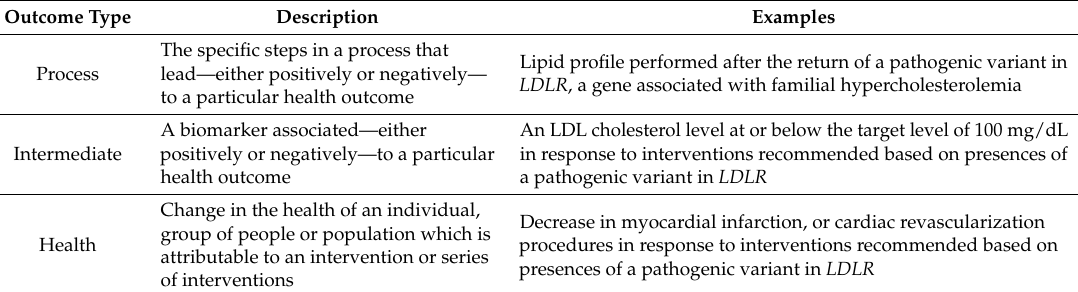
Table 1. The framework of outcomes for clinical